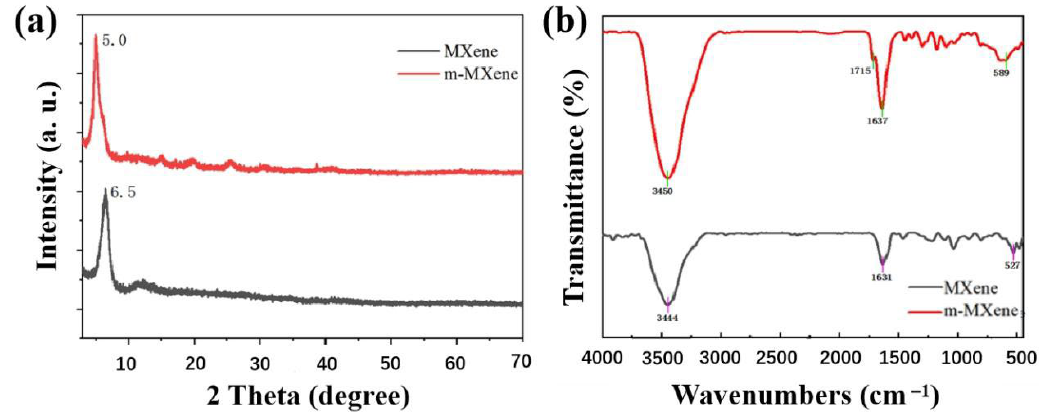
Figure 2. ( a ) XRD patterns of MXene and m-MXene; ( b ) FTIR spectra of MXene and m-MXene.